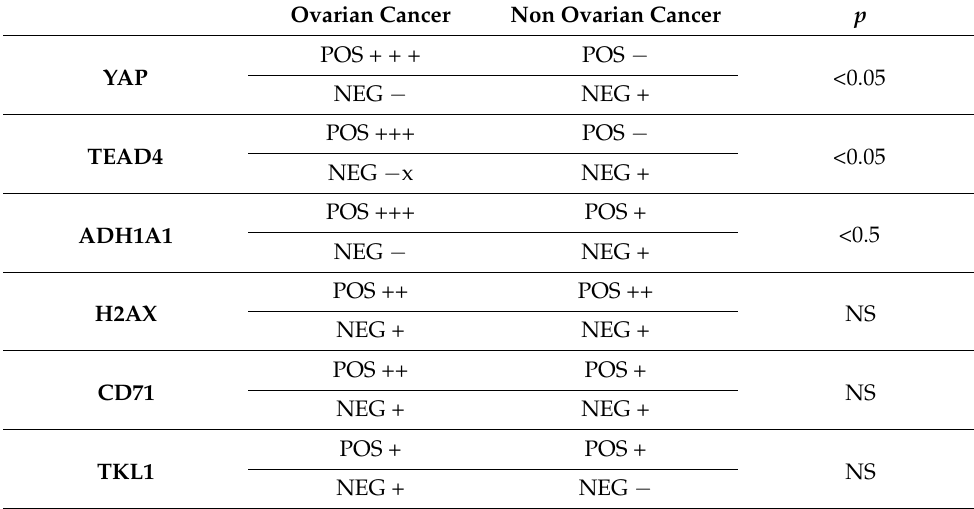
Ovarian Cancer Non Ovarian